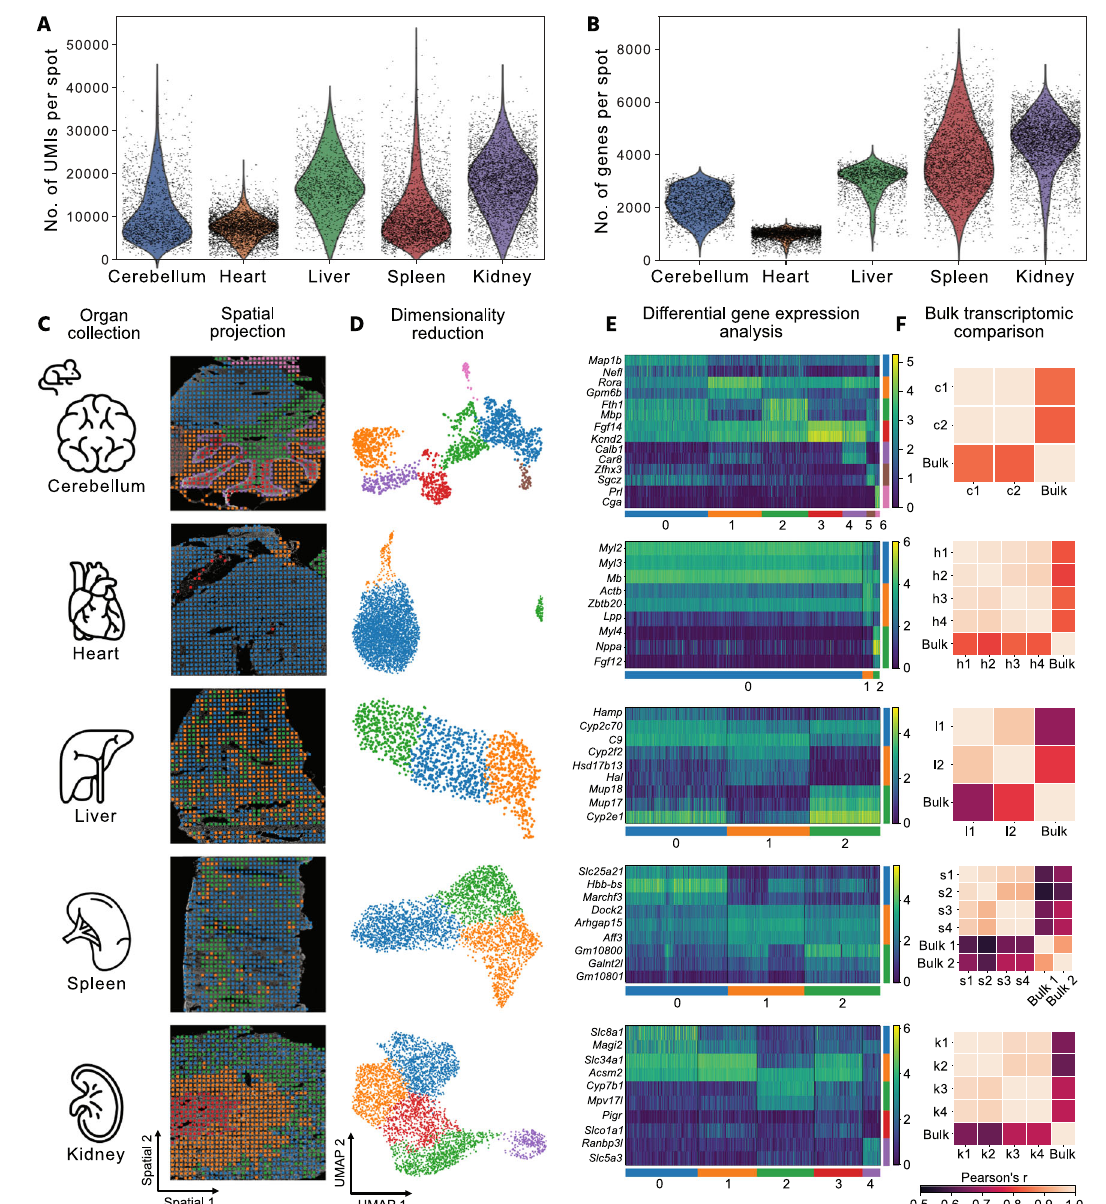
Fig.3|SpatialtranscriptomicsofmultiplemurineorganswithxDBiT.A , B UMI and gene counts per spot obtained with the xDBiT method for tissue sections of different murine organs. C Representative DAPI images of fi ve murine organs overlaidwithxDBiTspatialgeneexpression. D Two-dimensionalembedding ofthe xDBiT transcriptomic data using UMAP 28 . Each spot represents one xDBiT spot. Colors denote clusters that were determined using the Leiden algorithm 29 . E Top differentially expressed genes of the identi fi ed Leiden clusters within the corre- After preprocessing and dimensionality reduction using Uniform Manifold Approximation and Projection (UMAP) 28 , thedatashowed no algorithm 29 and projection of xDBiT spots onto the respective micro- differential gene expression (DGE) analysis between Leiden clusters